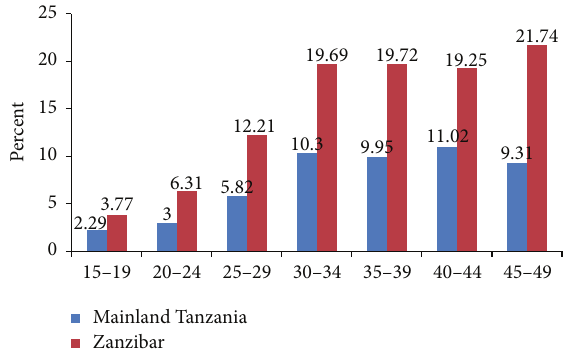
Figure 2: Percentage of women with obesity by age groups in Tanzania: Mainland and Zanzibar.